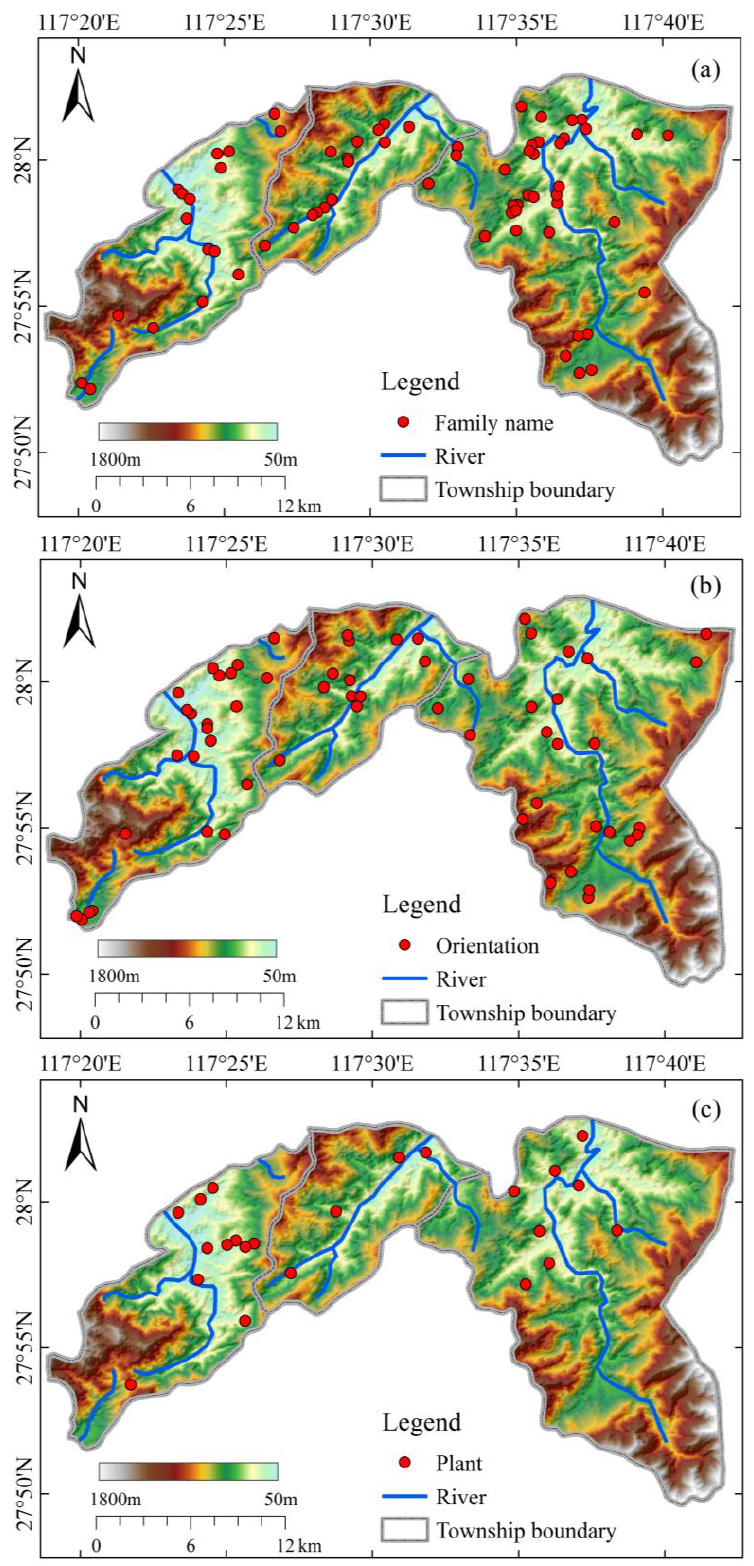
Figure 3. Distribution status of different types of toponymic points (( a ), family name; ( b ), orientation; ( c ),